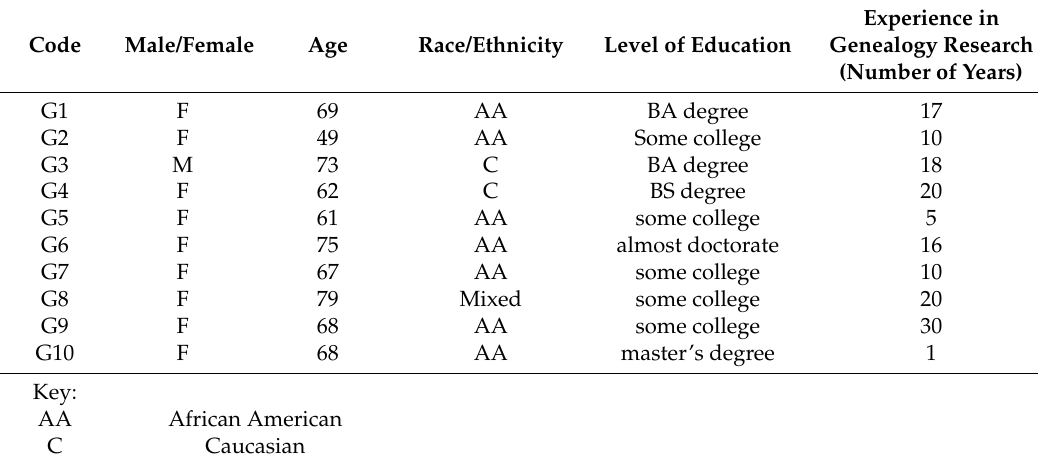
Table 1. Participant